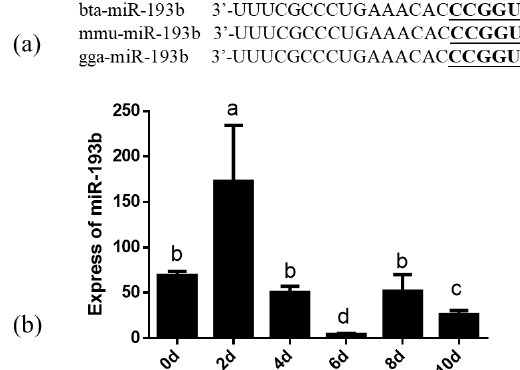
Figure 1. ( a ) The similarity analysis of miR-193b in cattle, mouse and chicken. The underlined font refers to the sequence of the seed. ( b ) The expression dynamics of bta-miR-193b during adipocyte di ff erentiation determined by RT-qPCR. Di ff erent letters (a, b, c and d) represent significant di ff erences as follows: p <